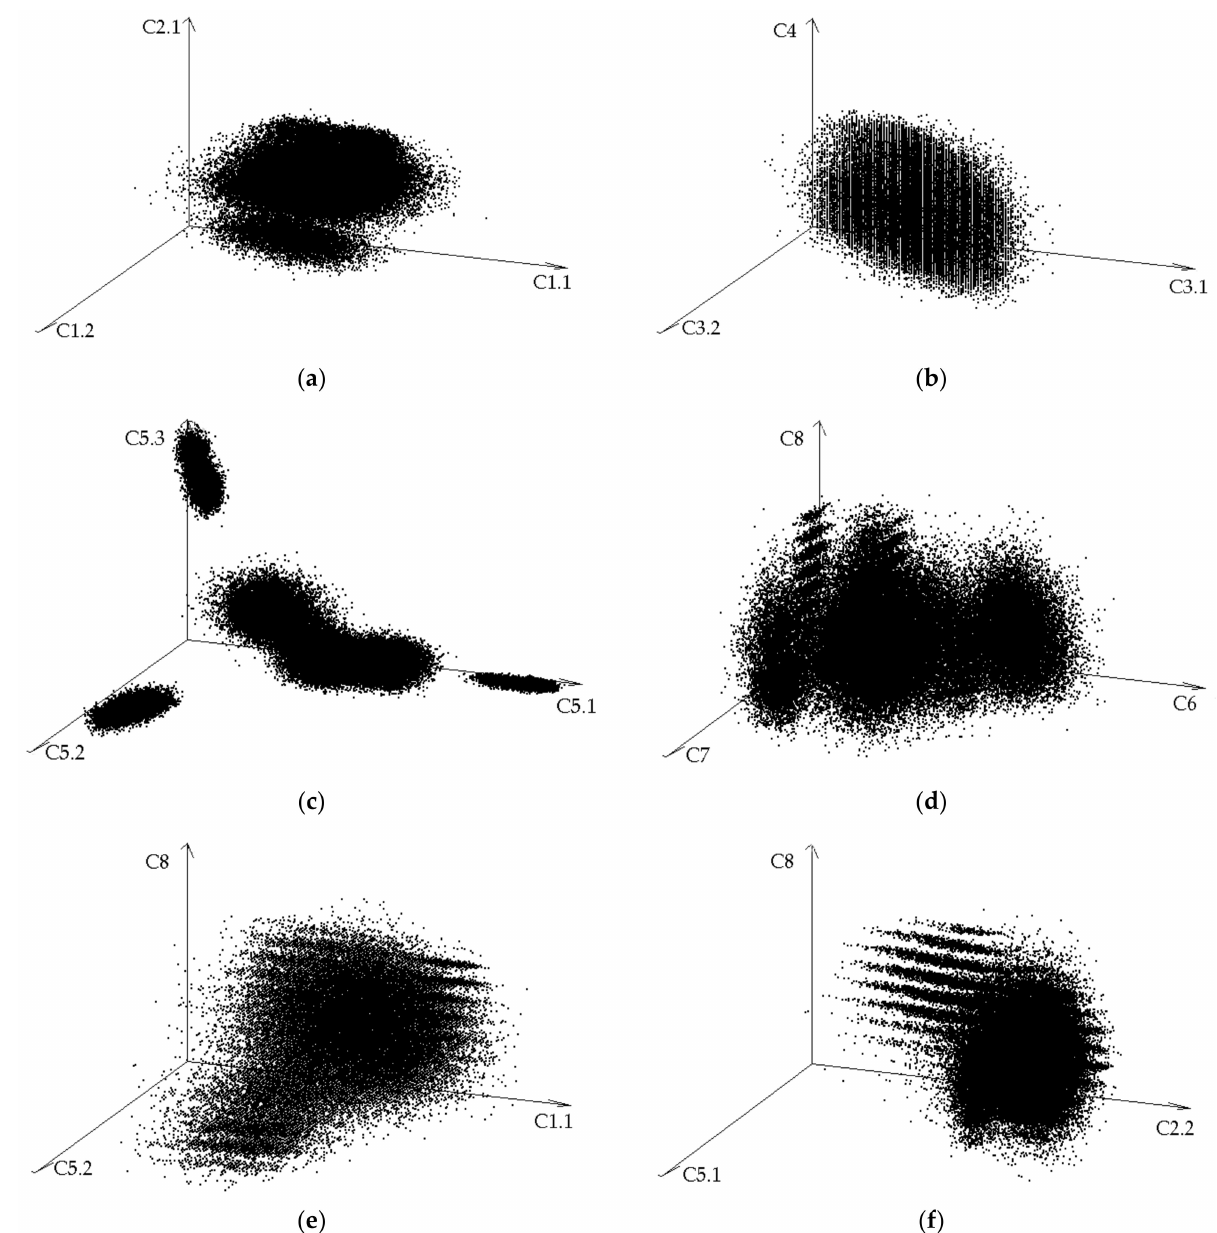
Figure 5. Selected 3D visualization of criteria values of the set of 71,599 Pareto-optimal alternatives: ( a ) X axis—criterion C1.1, Y—C1.2, Z—C2.1; ( b ) X axis—criterion C3.1, Y—C3.2, Z—C4; ( c ) X axis—criterion C5.1, Y—C5.2, Z—C5.3; ( d ) X axis—criterion C6, Y—C7, Z—C8; ( e ) X axis—criterion C1.1, Y—C2.1, Z—C8; ( f ) X axis—criterion C2.2, Y—C5.1,